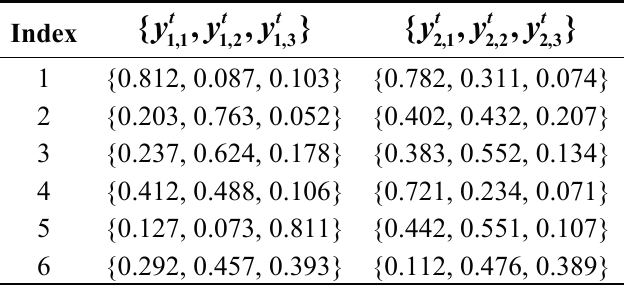
Table 6. Feature-level fusion